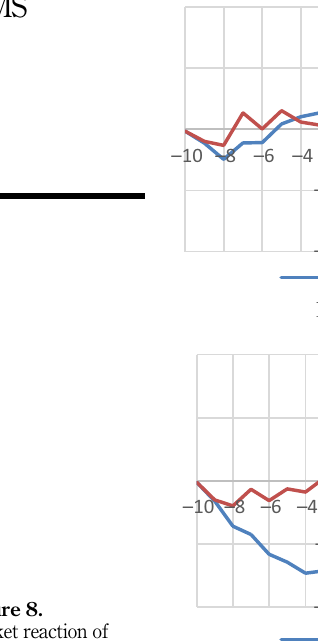
Figure 8. Market reaction